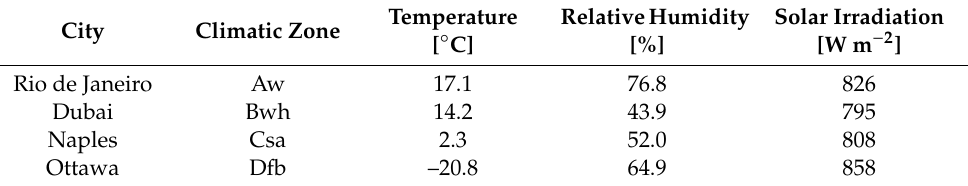
Table 3. Winter external design parameters [31].